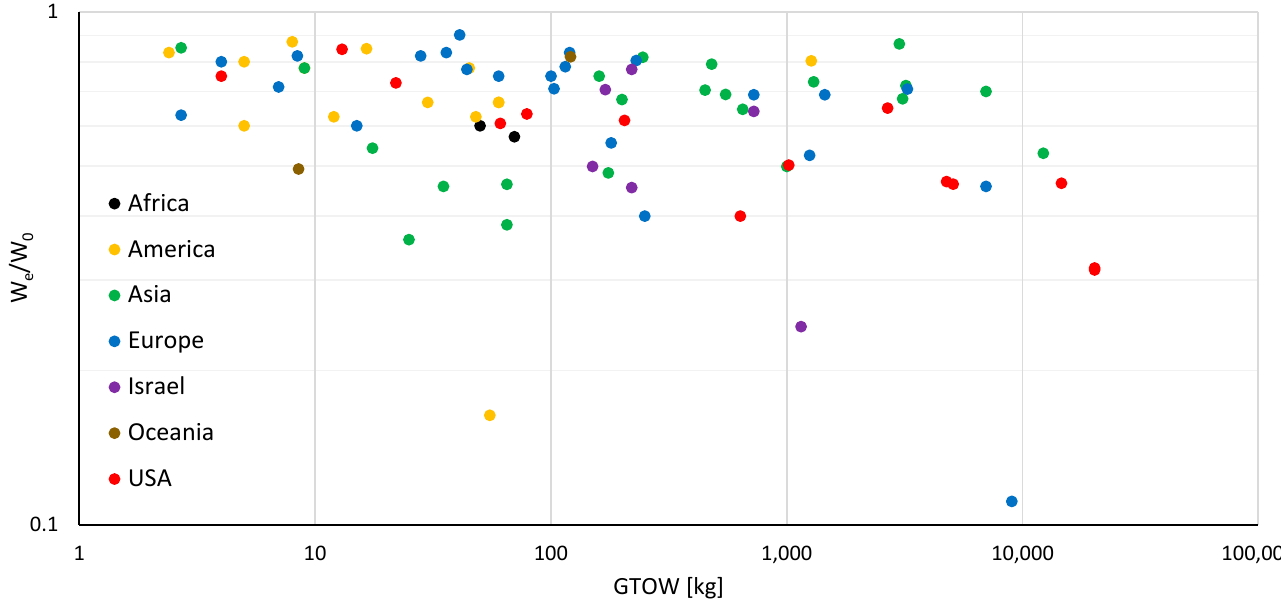
Figure 16. Empty weight divided by GTOW as a function of GTOW with respect to region of origin.